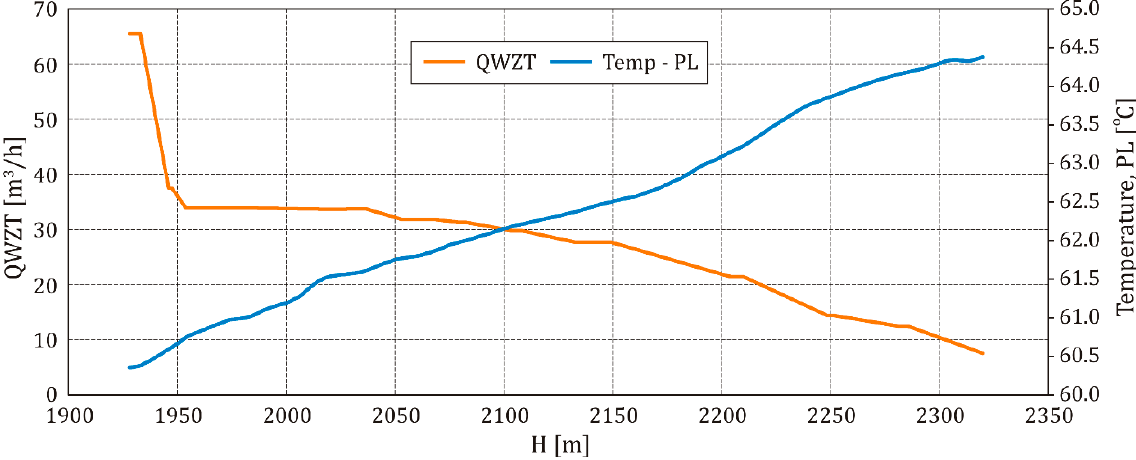
Figure 4. Results of Production Logging; total water flow rate, QWZT and temperature vs. depth, GT ‐ 2 borehole.